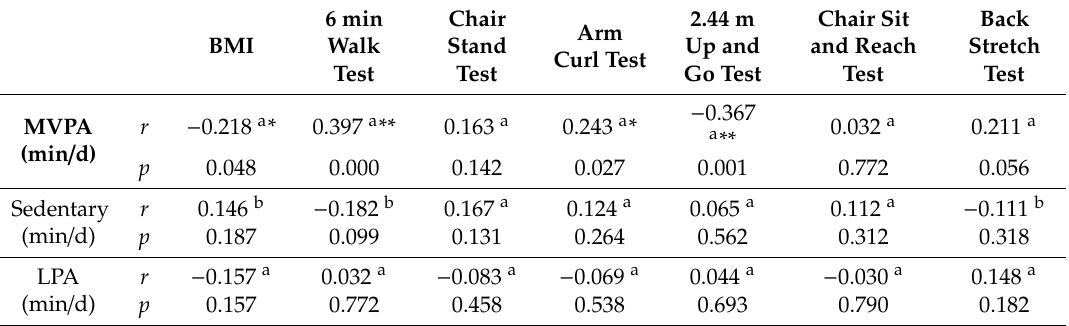
Table 2. Bivariate correlation between participants sedentary time and physical activity levels with physical